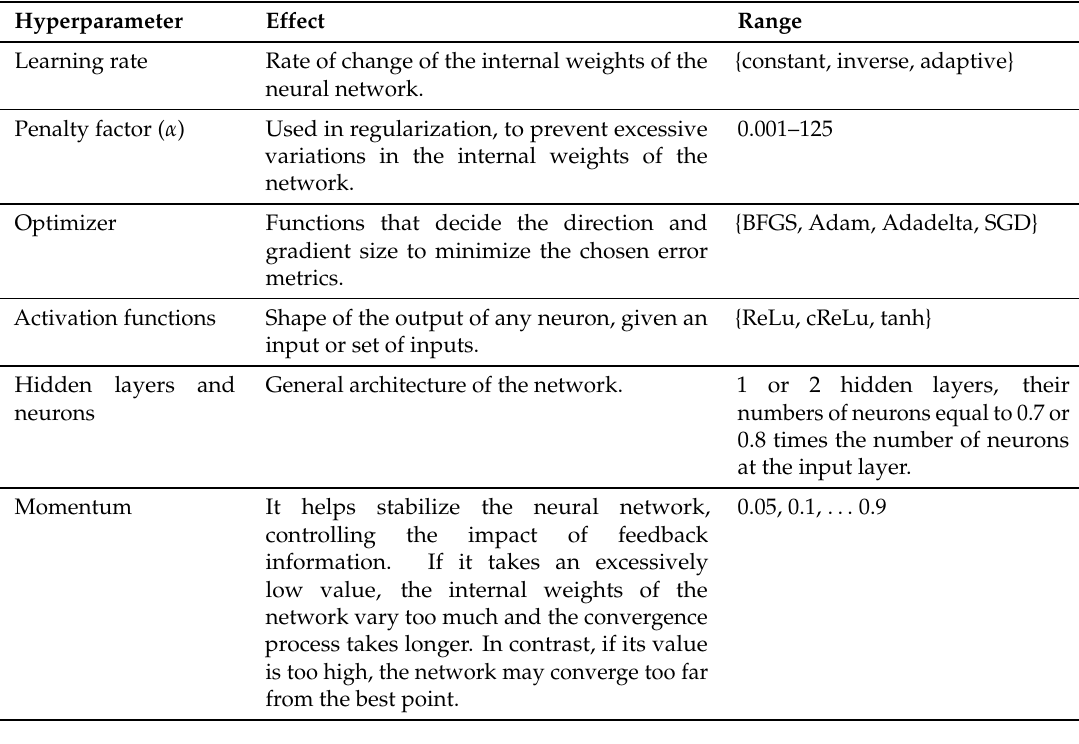
Table 2. Ranges of values for the Multi-Layer Perceptron (MLP)